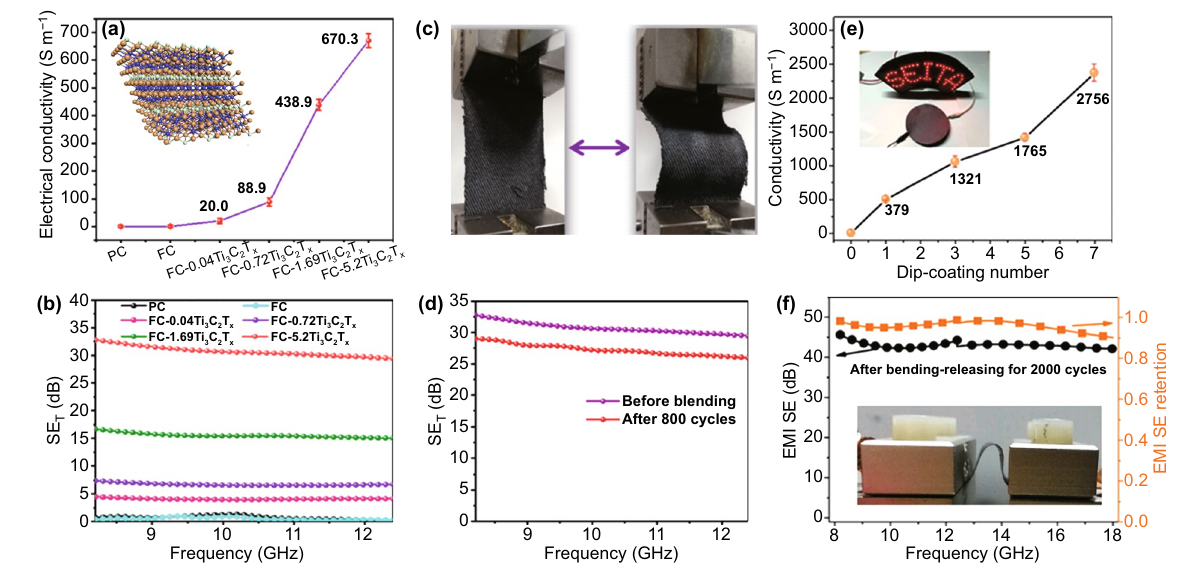
Fig. 8 a Electrical conductivity and b EMI shielding performance of samples in X‑band. c Process of bending test and d EMI shielding per‑ formance of FC‑5.2Ti 3 C 2 T x before and after 800 cycles bending test. Reproduced with permission from Ref. [112]. Copyright 2020, American Chemical Society. e Electrical conductivity of M‑filter as a function of dip‑coating cycles. f EMI SE of the PM‑7 after 2000 bending‑releasing cycles and the EMI SE retention. Reproduced with permission from Ref. [113]. Copyright 2020,